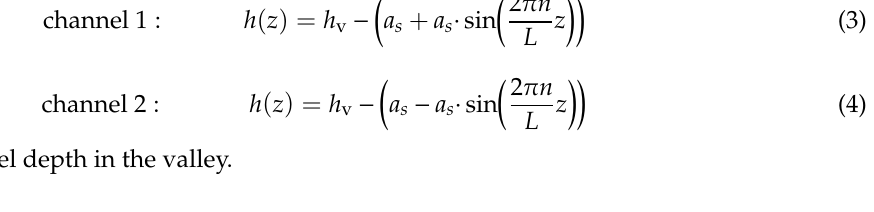
Table 3. Temperature profiles in °C.